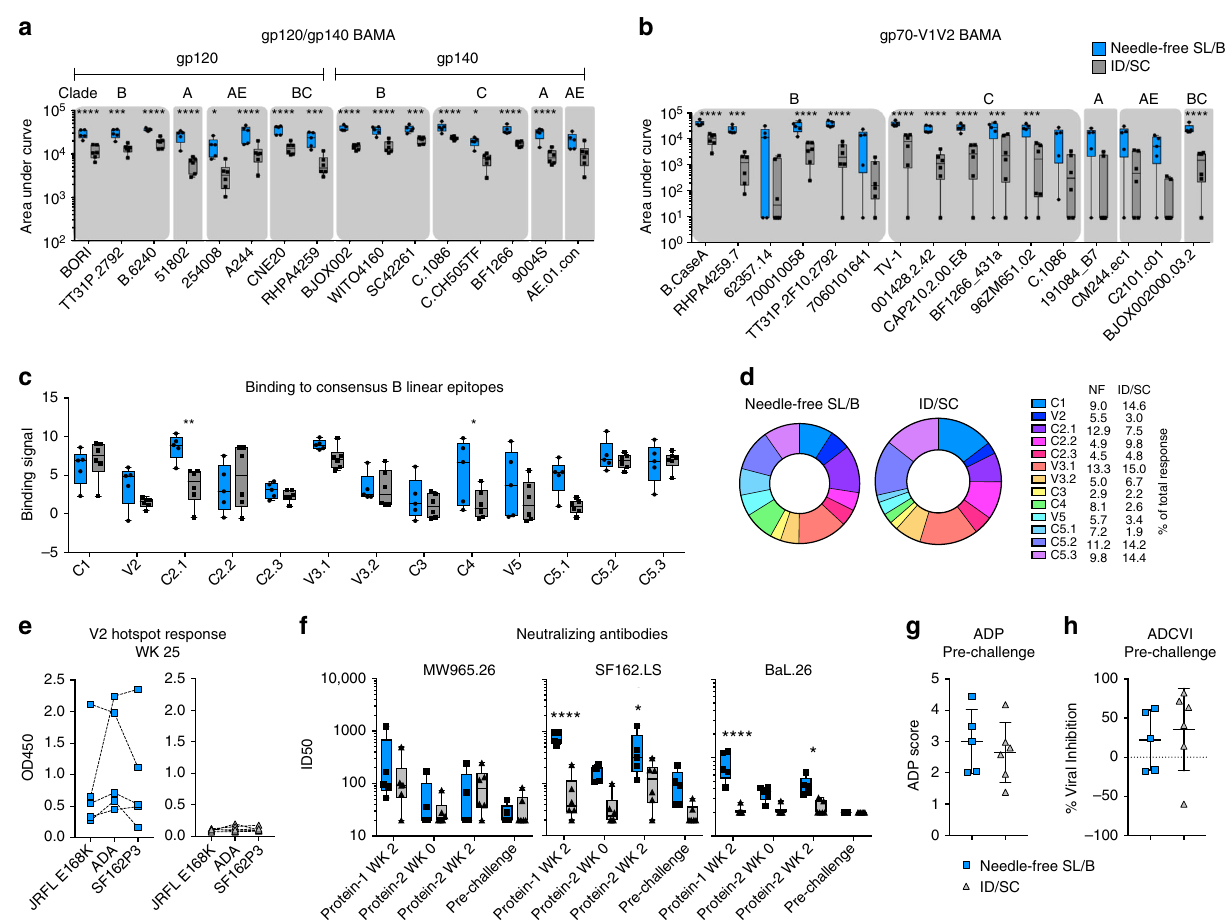
Fig. 4 Serum IgG speci fi city, neutralizing activity, and effector function. Binding of IgG antibodies at two weeks post the fi rst cycP-gp120 immunization (wk 25) to a gp120 and gp140 antigens and b gp70-V1V2 scaffolds representing the global diversity of HIV-1 determined using Binding Antibody Multiplex Assay (BAMA). Shaded areas indicate clade. c Binding of peak immune sera (wk 25) to 15mer peptides derived from clade B consensus gp120, measured by peptide microarray linear epitope mapping and reported as binding signal (Log2 fold difference post-immunization/baseline binding intensity). Magnitude of binding to each epitope is de fi ned as the highest binding signal for a single peptide within the region of the epitope. d Representation of peptide array binding of each clade B consensus epitope as % of the total response. e Anti-V2 hotspot (HS) response (wk 25) against V2-HS peptides derived from strains JRFL (E168K), ADA, and SF162P3 measured by ELISA. Dotted lines connect data from same animal. Blue squares, needle-free SL/B; gray triangles, ID/SC. f Neutralizing antibodies over time against HIV-1 isolates MW965.26, SF162.LS, and BaL.26, measured as ID50. g Antibody- dependent phagocytosis (ADP) at pre-challenge (wk 45). ADP score (mean ± S.D.) calculated for each serum by dividing the median fl uorescence intensity (MFI) of bead positive cells by the value obtained using the same dilution of pooled serum from naive macaques. h Antibody-dependent cell viral inhibition (ADCVI) measured at pre-challenge as % viral inhibition (mean ± S.D.). An average of two individual experiments is shown. Box and whiskers plots ( a – c , f ); box extends from 25th to 75th percentile, line indicates median, whiskers indicate min and max values (* p < 0.05; ** p < 0.01; *** p < 0.001; ****, p < 0.0001; 2-Way ANOVA, multiple comparisons). ID50, serum dilution required to neutralize 50%